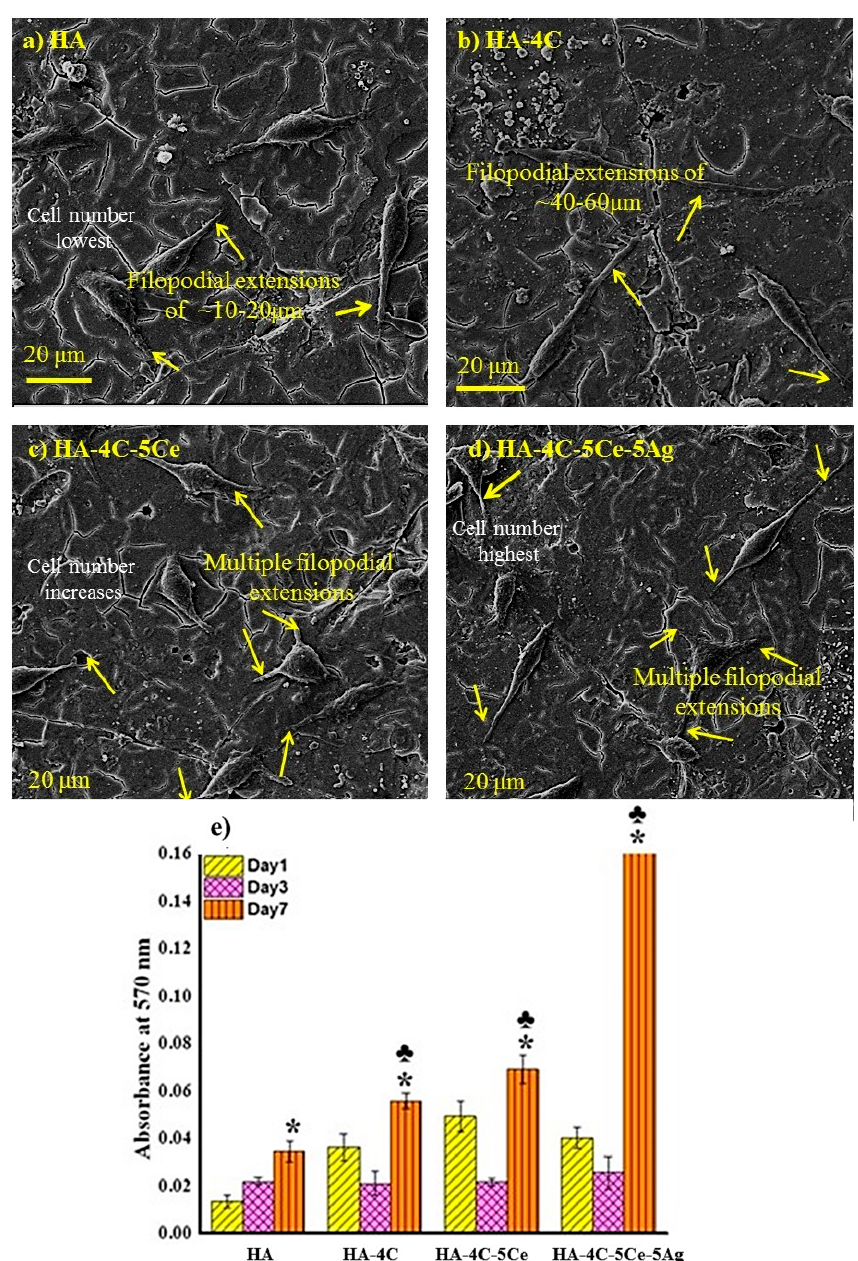
Figure 10. Scanning electron micrographs ( a – d ) and quantitative estimation ( e ) of L929 cells on HA-based plasma sprayed coatings. * Indicates p values of <0.007 for cell density average at day 7 of composites when compared to day 7 HA control. The average of the obtained cell number on day 7 composites in comparison to that of same composites on day 1 and ♣ depicts p value of <0.001.